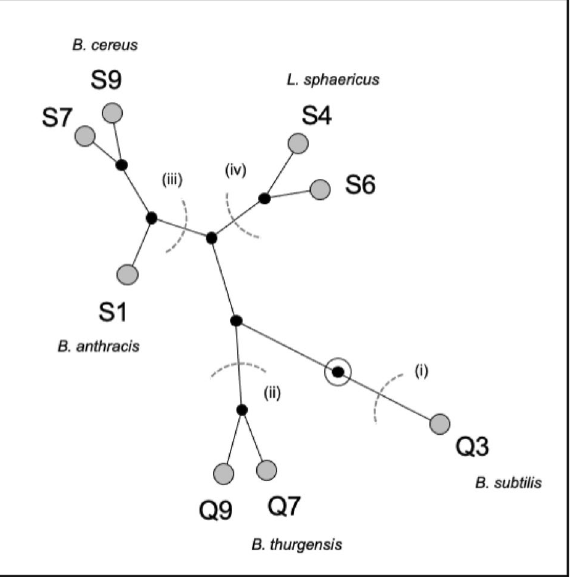
Figure 2. Shown here is a HCA constellation plot which clusters similar strains in terminal (short) branches and links strains with greater differences with longer branches. The plot is arbitrarily rooted mid-way along the longest branch (circled) and the four major groups (grey arcs) determined automatically. Those strains that have been identified by 16S rDNA analysis are